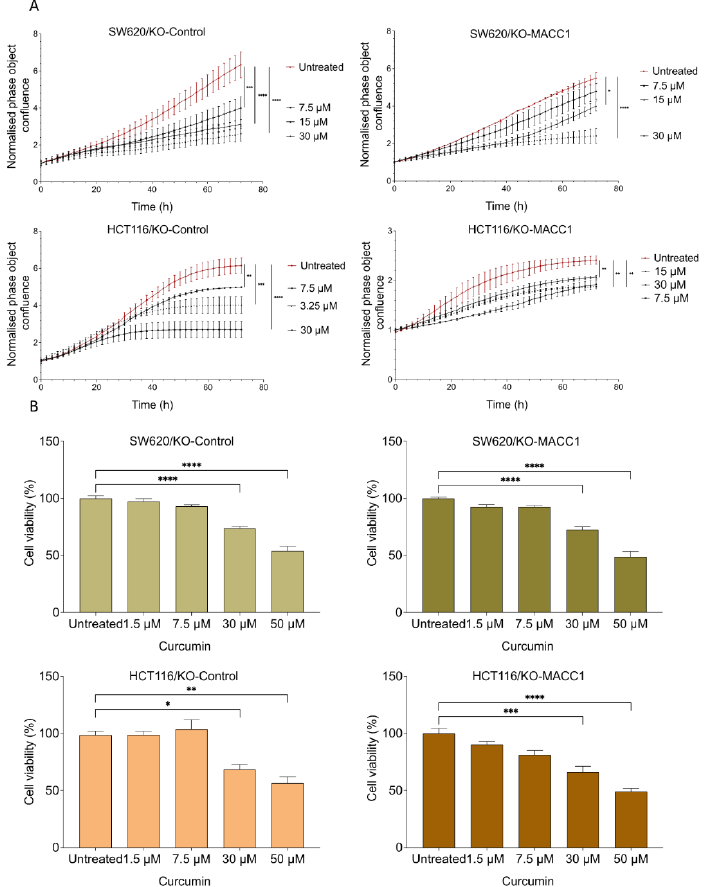
Figure 2. Curcumin reduced proliferation and viability of CRC cell lines with high or moderate MACC1 expression. CRC cells were treated with various concentrations of curcumin. Every 2 h, the confluency of the cells was assessed by a cell imaging system. Curcumin significantly reduced the proliferation of the cells with high or moderate MACC1 expression (SW620/KO-Control, HCT116/KO-Control) ( A ). Cell viability was determined using the MTT assay. Viability of the CRC cells was reduced upon curcumin treatment in a dose-dependent manner ( B ). Data represent mean ± SEM ( n ≥ 3), * = p < 0.05, ** = p < 0.01, *** = p < 0.001, **** = p < 0.0001.